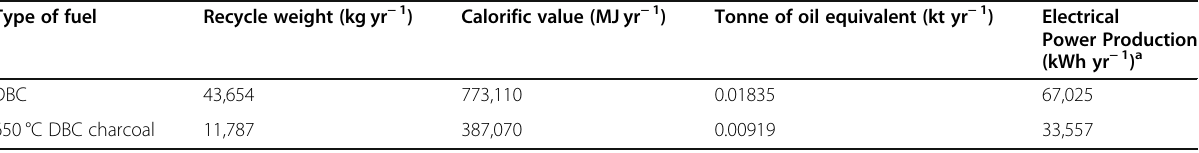
Table 3 Estimation of renewable energy production from DBC and 650 °C DBC charcoal Type of